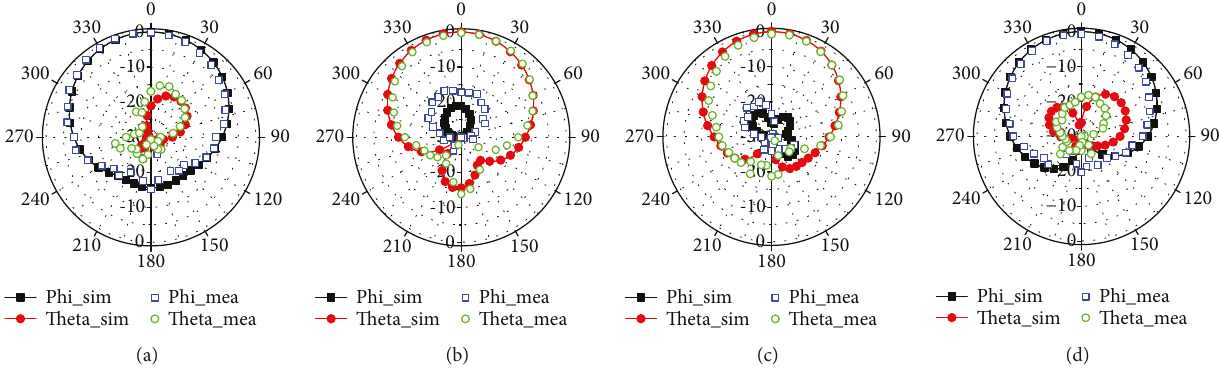
Figure 7: Measured radiation patterns of antenna 1: (a) yz -plane at f